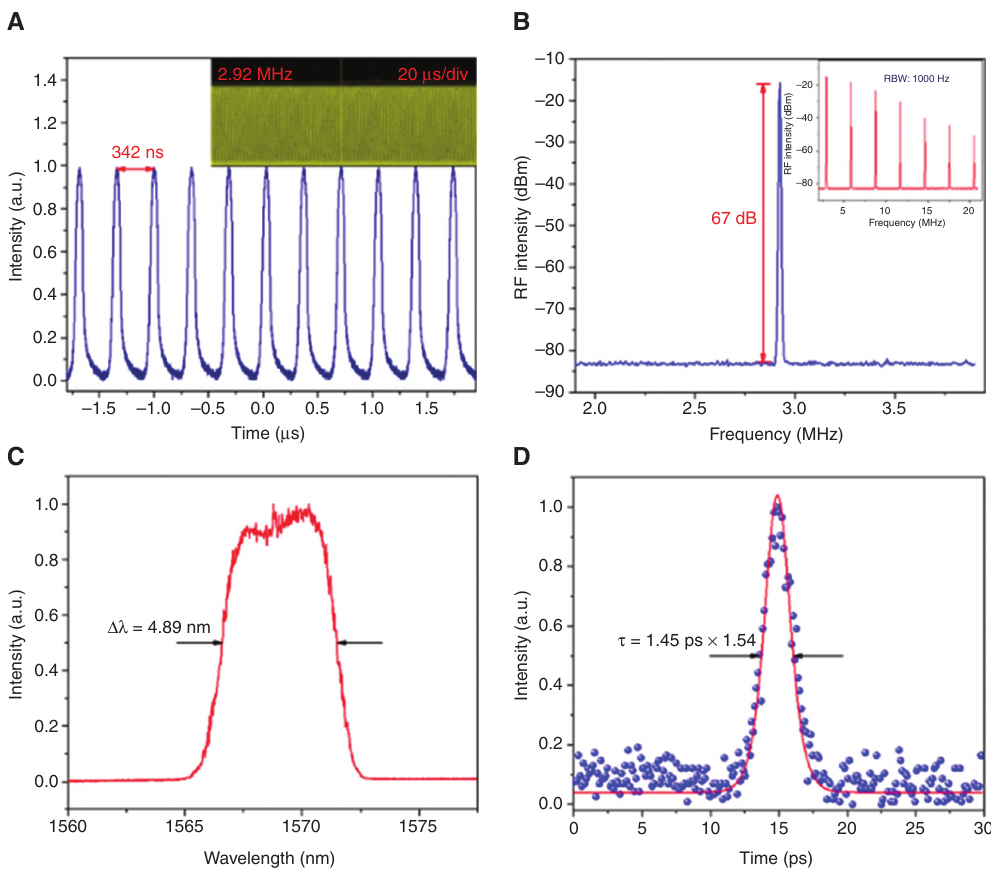
Figure 8: The results of mode-locked EDFL. (A) Pulse trains of mode-locking operation at a pump power of 320 mW. Inset: Oscilloscope trace. (B) RF spectra. (C) Optical spectrum. (D) Autocorrelation trace for the output